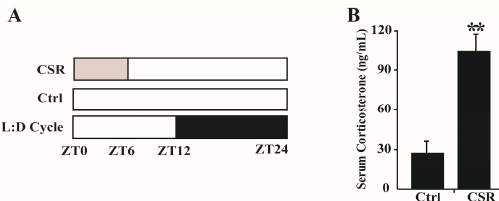
Figure 1. A rat model of CSR was successfully constructed: ( A ) Schematic overview of sleep restriction protocol for CSR and control rats. For CSR rats, period of forced wakefulness was shown in light grey from ZT0 to ZT6 each day while control rats were left undisturbed; ( B ) Serum concentration of corticosterone was measured after CSR., ** p < 0.01 vs. control. n = 10.